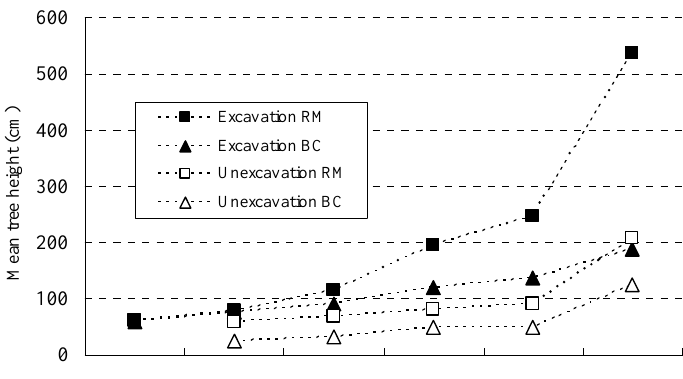
Figure 7. The mean tree height from 5 months to 10 years after planting. RM— Rhizophora mucronata , BC— Bruguiera cylindrica.